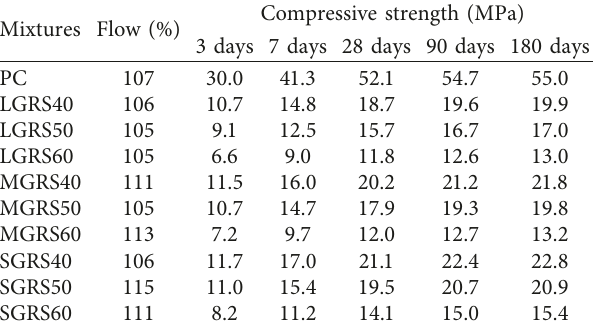
Table 5: Compressive strengths of mortars containing ground